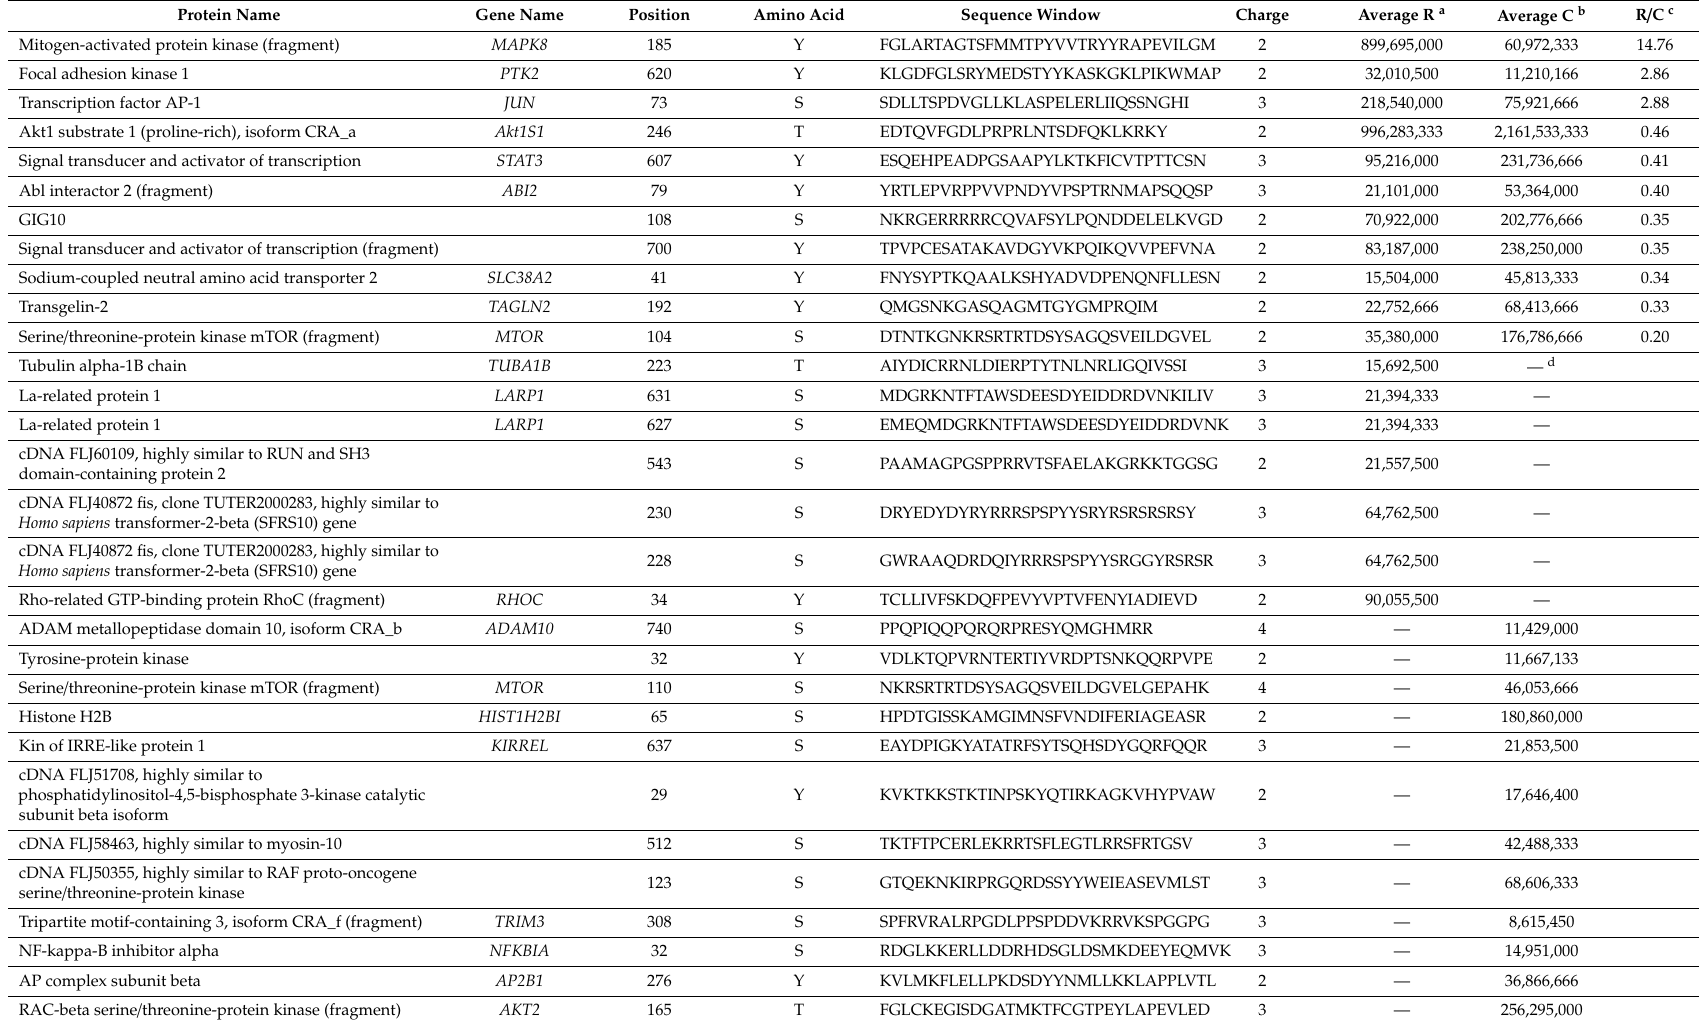
Table 1. Di ff erentially expressed phosphoproteins between the rotenone group and control